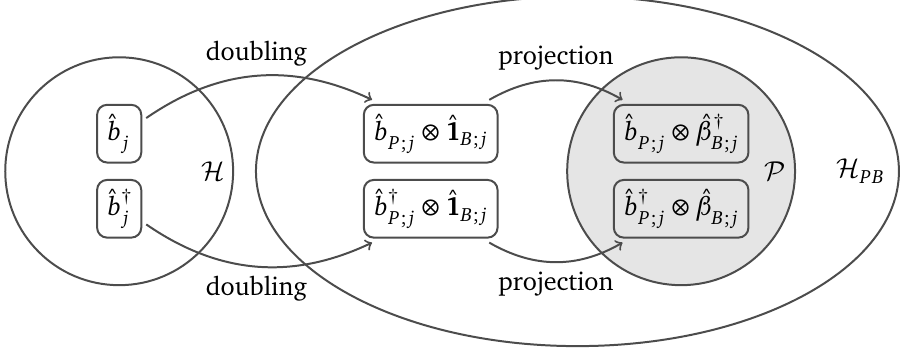
Figure 1: Mapping of local operators ˆ b local operators ˆ b